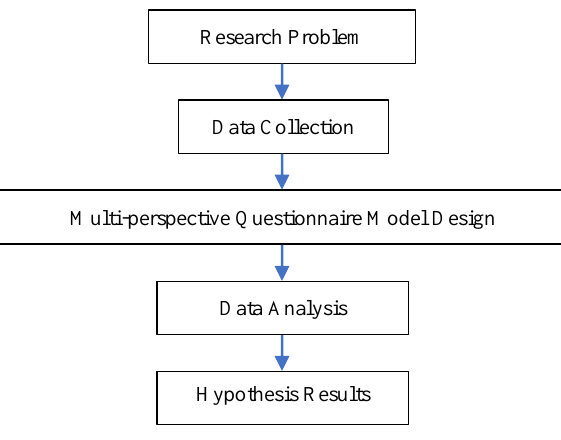
Figure 2. The Research Methodology Flow Chart.